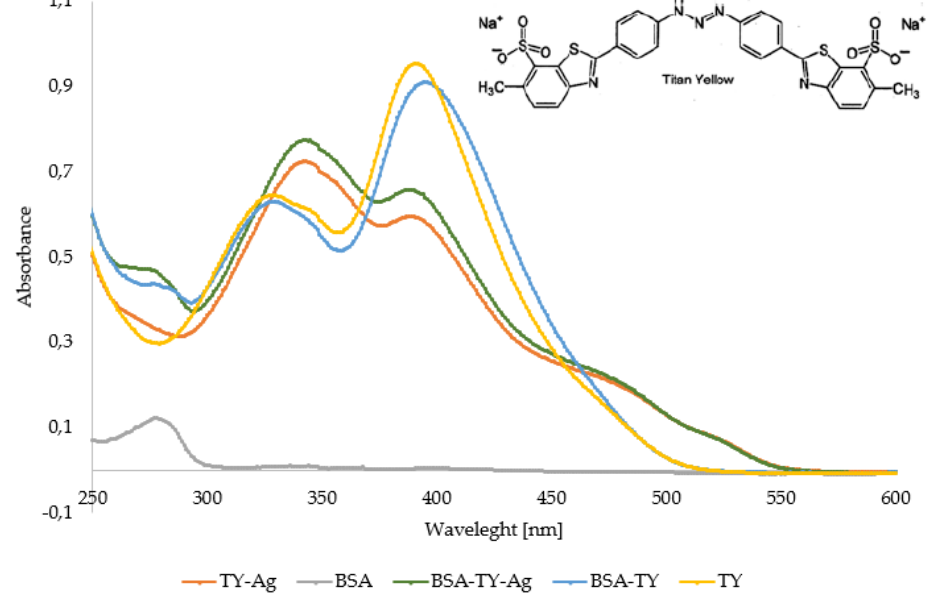
Figure 3. Comparison of UV/VIS spectra of TY, TY-Ag, BSA, BSA-TY, and BSA-TY-Ag. Changes in the spectrum in the emerging complexes are visible.